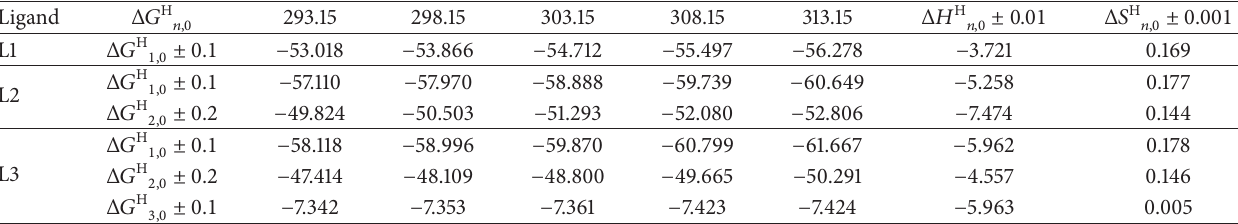
Table 9: The standard thermodynamic parameters of protonation process (( Δ𝐺 H 𝑛,0 kJmol −1 ), ( Δ𝐻 H 𝑛,0 kJ mol −1 ), and ( Δ𝑆 H 𝑛,0 kJ mol −1 ⋅ K −1 )) of L1, L2, and L3 at different temperatures ( 𝑇 /K).